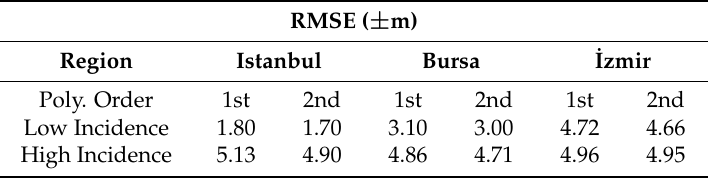
Table 2. RMSE results of the first- and second-order refinement